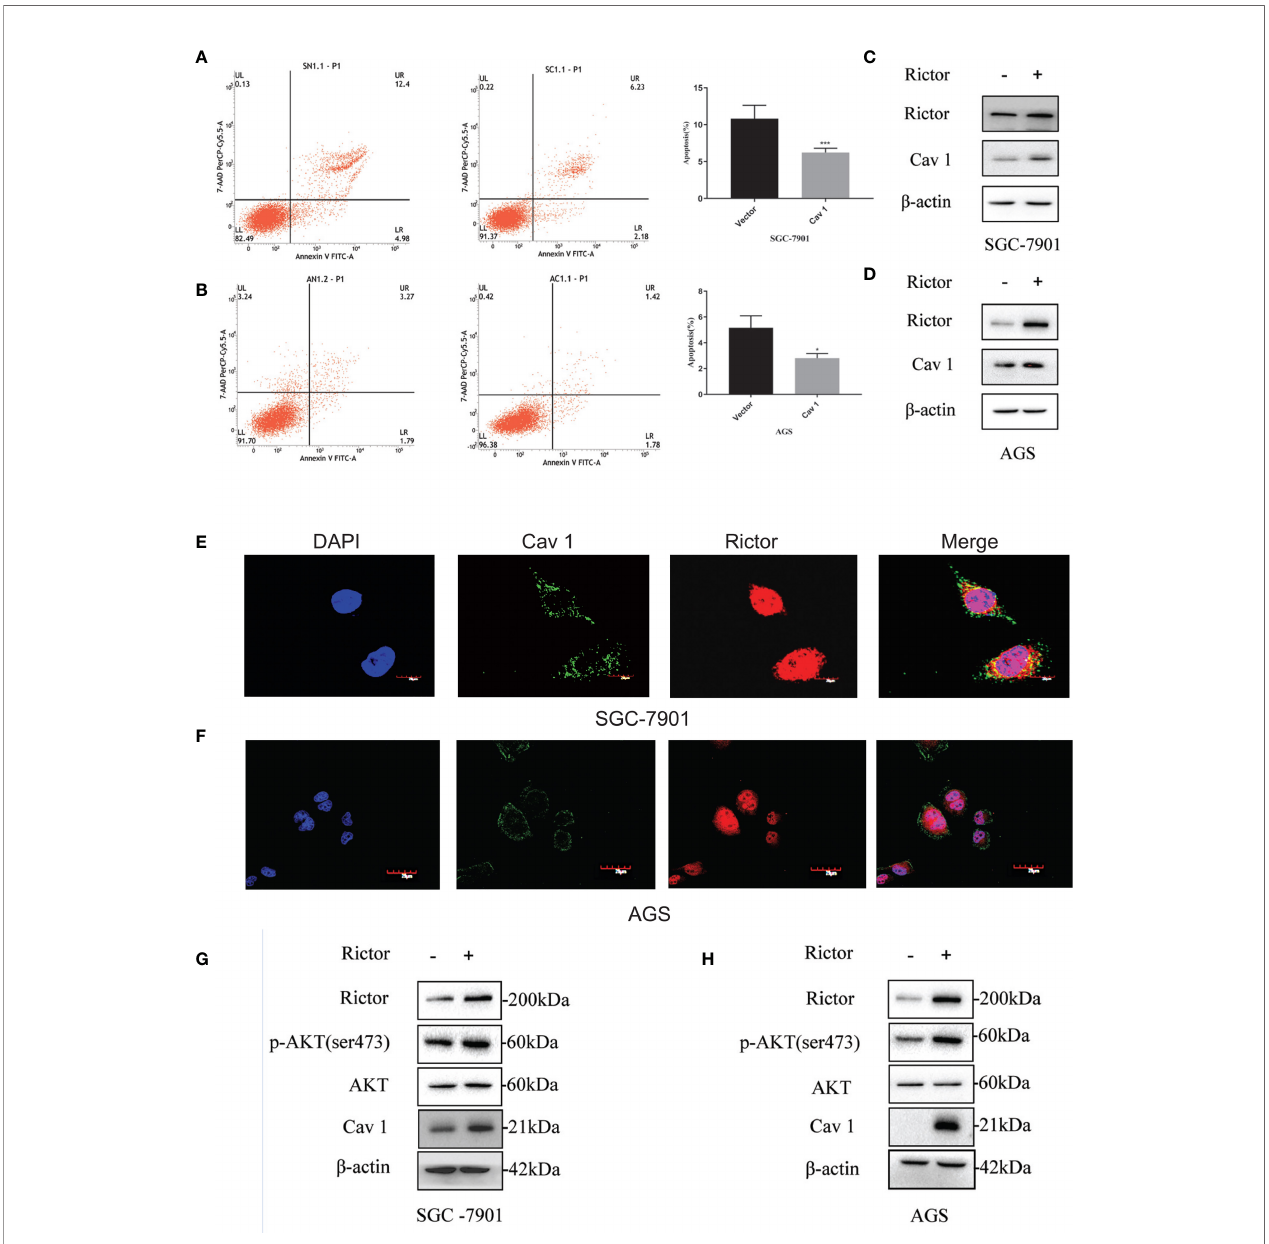
FIGURE 4 | Cav 1-induced inhibition of apoptosis of gastric cancer cells and association between Rictor and Cav 1. (A) Transfected Cav 1 plasmid could inhibit the apoptosis of SGC-7901 cells (n=9). (B) Transfected Cav 1 plasmid could inhibit the apoptosis of AGS cells (n=9). Values represent the Means ± SD, *P < 0.05 and ***P < 0.001 were calculated using Student ’ s t-test. (C) Western blot analysis of the increase of Cav 1 expression with Rictor overexpression in SGC-7901 cells. (D) Western blot analysis of the increase of Cav 1 expression with Rictor overexpression in AGS cells. (E, F) Immuno fl uorescence showed no co-localization between Rictor and Cav 1. (G) Western blot analysis of p-Akt and Cav 1 levels increased after transfection of SGC-7901 cells with Rictor plasmid. (H) Western blot analysis of p-Akt and Cav 1 levels increased after transfection of AGS cells with Rictor plasmid. b -actin served as a loading